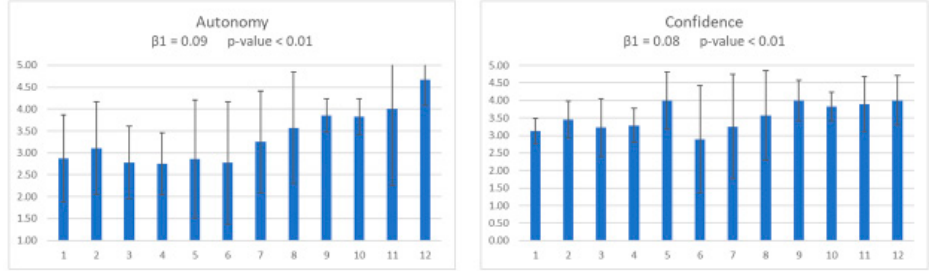
Figure 3. Fortnightly means and SD for the “autonomy” and “confidence” variables. Significant enhancements were observed in the two variables ( p < 0.01).